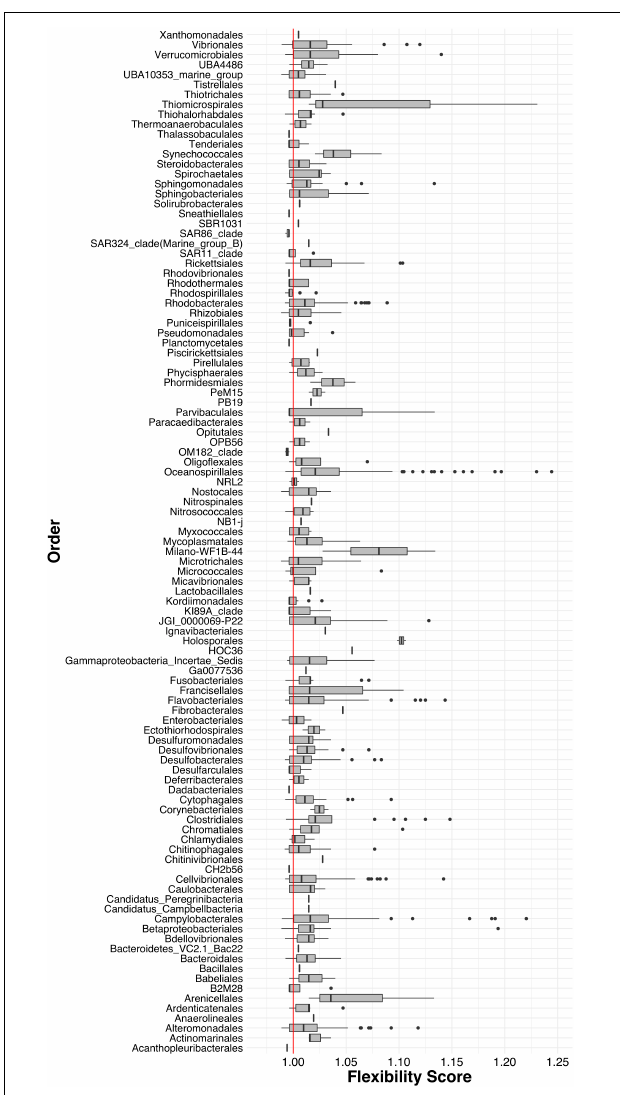
FIGURE 5 | Box and whiskers plots of the flexibility scores of ASVs grouped by Order. Red line indicates a flexibility score of 1.